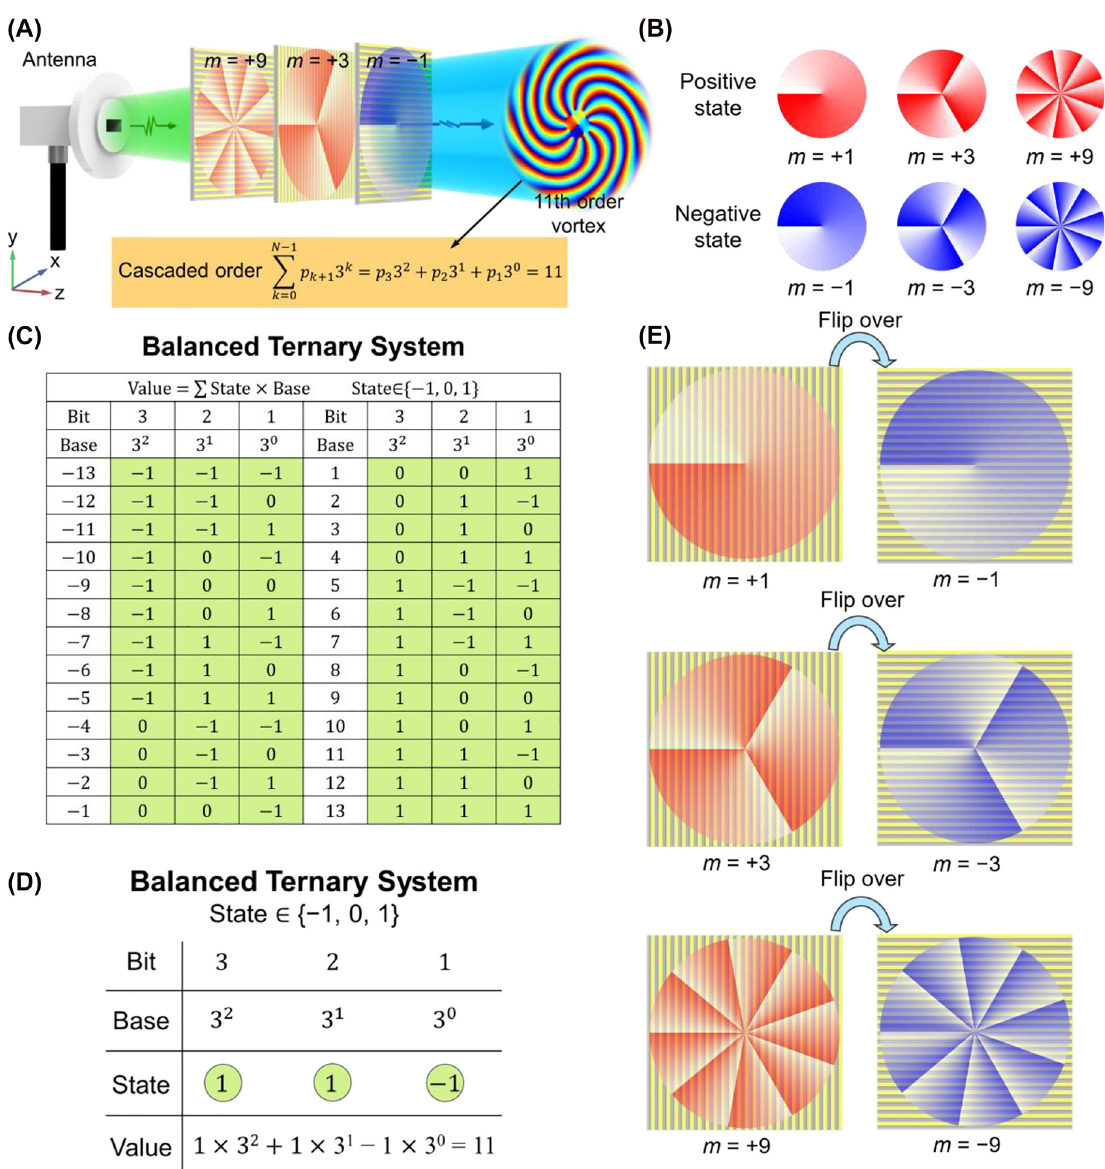
Figure 1: Schematic illustration of the proposed order-controllable vortices generation method based on cascaded metasurfaces. (A) Generation of an 11th order vortex beam is taken as an examplein this illustration. An antenna radiates an incident EM beam. Three BVGs, i.e., order-1, order-3, and order-9, are cascaded to implement the generation of the 11th order vortex. The order-3 and order-9 BVGs are con fi guredtogeneratepositive-order m = + 3and m = + 9vorticesinthecascadingsequence,whiletheorder-1BVGiscon fi guredtogeneratea negative-order m = − 1 vortex in the cascading sequence, which results in the fi nal vortex order of m f = 9 + 3 − 1 = 11. (B) Schematic transverse phase pro fi les of the six vortex orders used in the cascading sequence. (C) Balanced ternary system for the expression of numbers from − 13to − 1and1to13.(D)istheexampleexpressingthenumber11bythebalancedternarysystem.(E)Illustrationsshowingthat fl ippinga transmissive-metasurface-made order- m BVG can generate a vortex of inverse order − m “ + 1 ” in the ( k + 1)th bit corresponds to the presence of order-3 k BVG in cascading sequence to launch m = 3 k vortex, and the state “ 0 ” in the ( k + 1)th bit represents the absence or a void of order-3 k BVG in the cascading. Since a fl ipped vortex beam generator can render the